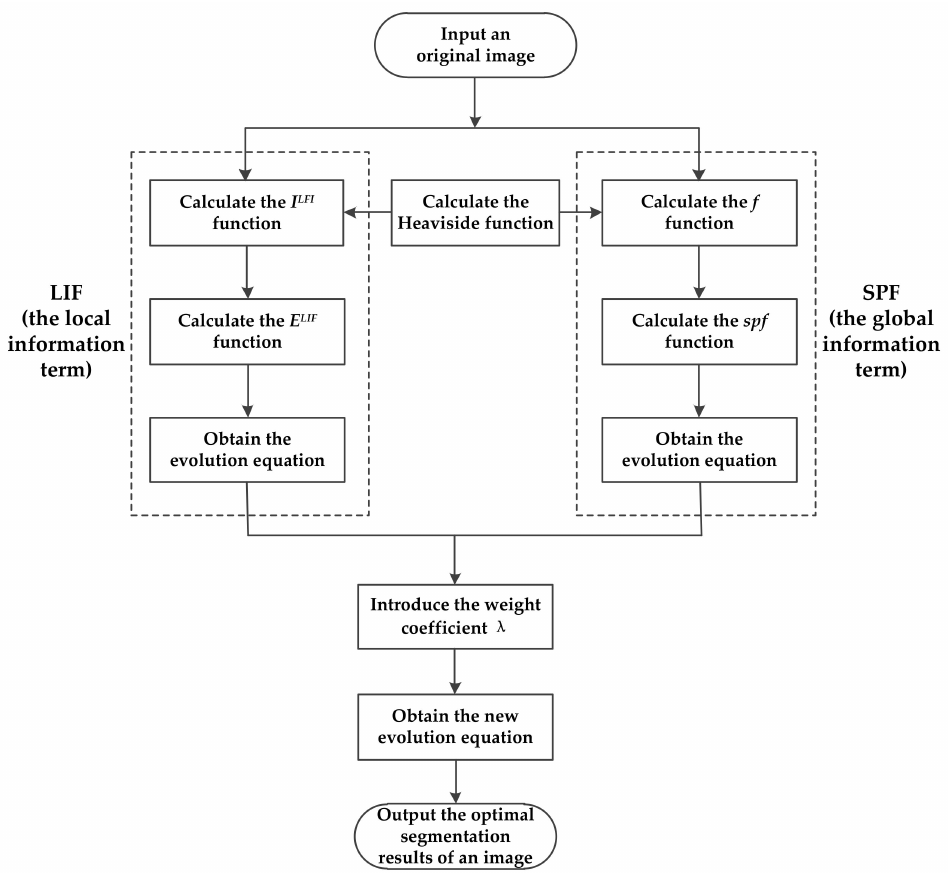
Figure 1. The graphical process of image